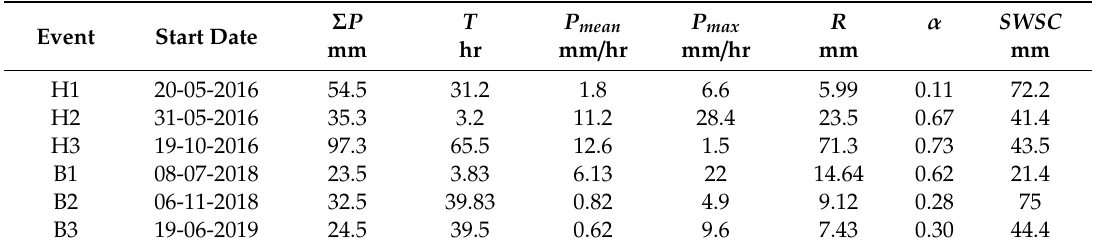
Table 3. Summary of rainfall and runo ff characteristics for the six selected rainfall